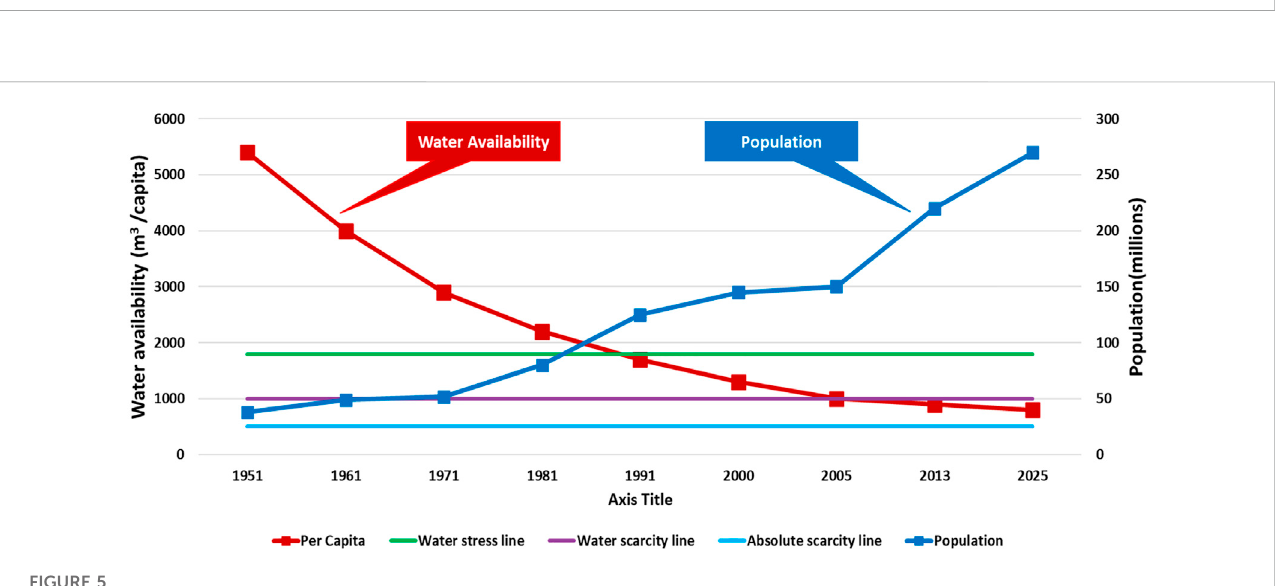
FIGURE 5 Pakistan ’ s water availability and demand by